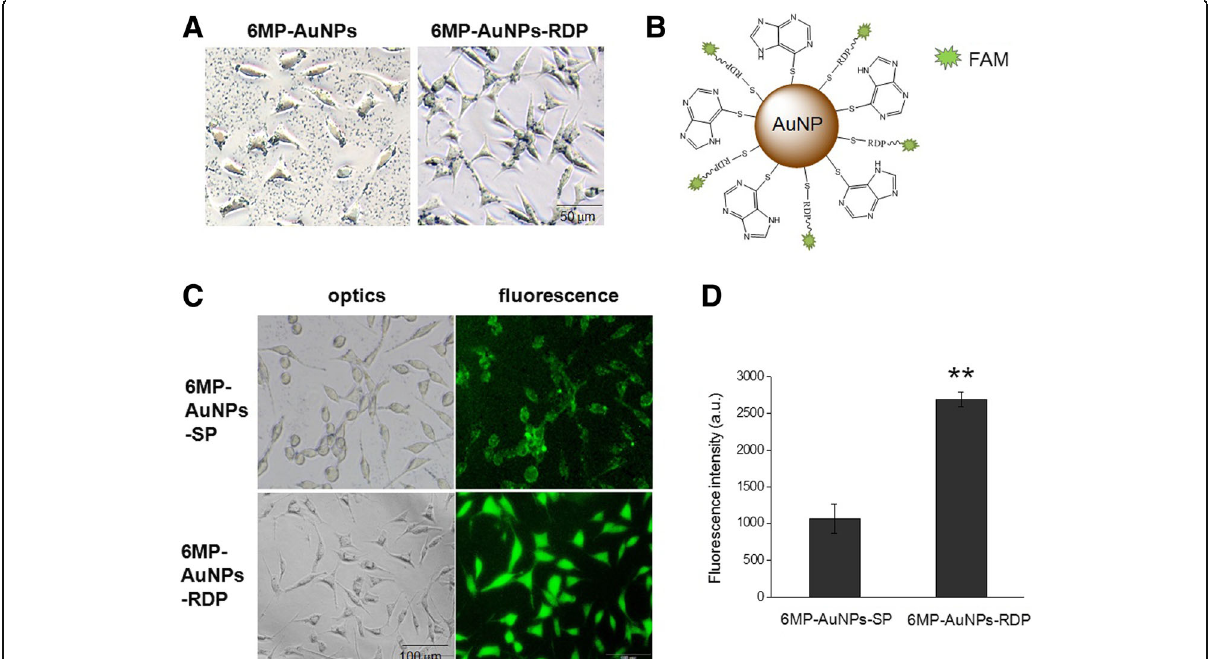
Fig. 3 Cell uptake of the nanoparticles. a 6MP-AuNPs and 6MP-AuNPs-RDP solutions of 0.25 μ g/mL were respectively adjusted to pH 7.4 and added into the cell media for a 30-min incubation. The particles were internalized into SH-SY5Y cells or precipitated on well bottoms. b Schematic diagram of 6MP- and fluorescence-labeled peptide-modified AuNP. After the SH-SY5Y cells were incubated with the particles for 2 h, images were taken ( c ) and fluorescence intensity ( d ) was measured. Data are presented as mean ± SEM. The values were averaged for four independent experi-